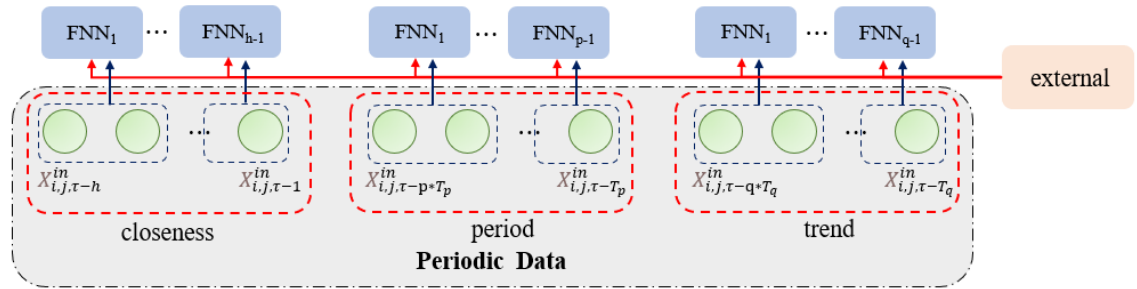
Figure 10. Structure of the Periodic Data module.